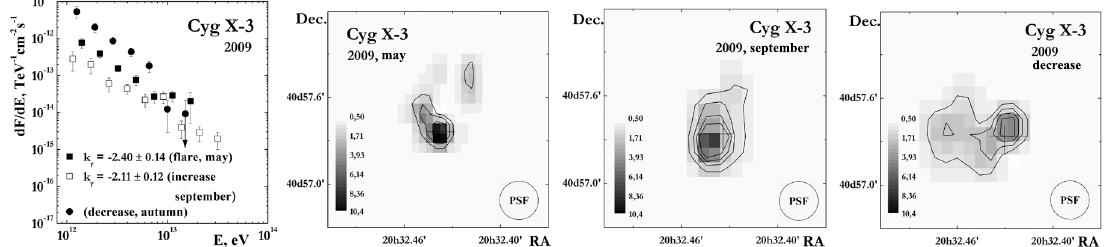
Figure 5. Di ff erential spectra of the γ -ray emission from CygX-3 during its flux increase in May 2006 and flux decrease in August. Images of Cyg X-3 at energies > 0 . 8 TeV during its flux increase in May 2006 and flux decrease in August 2006.